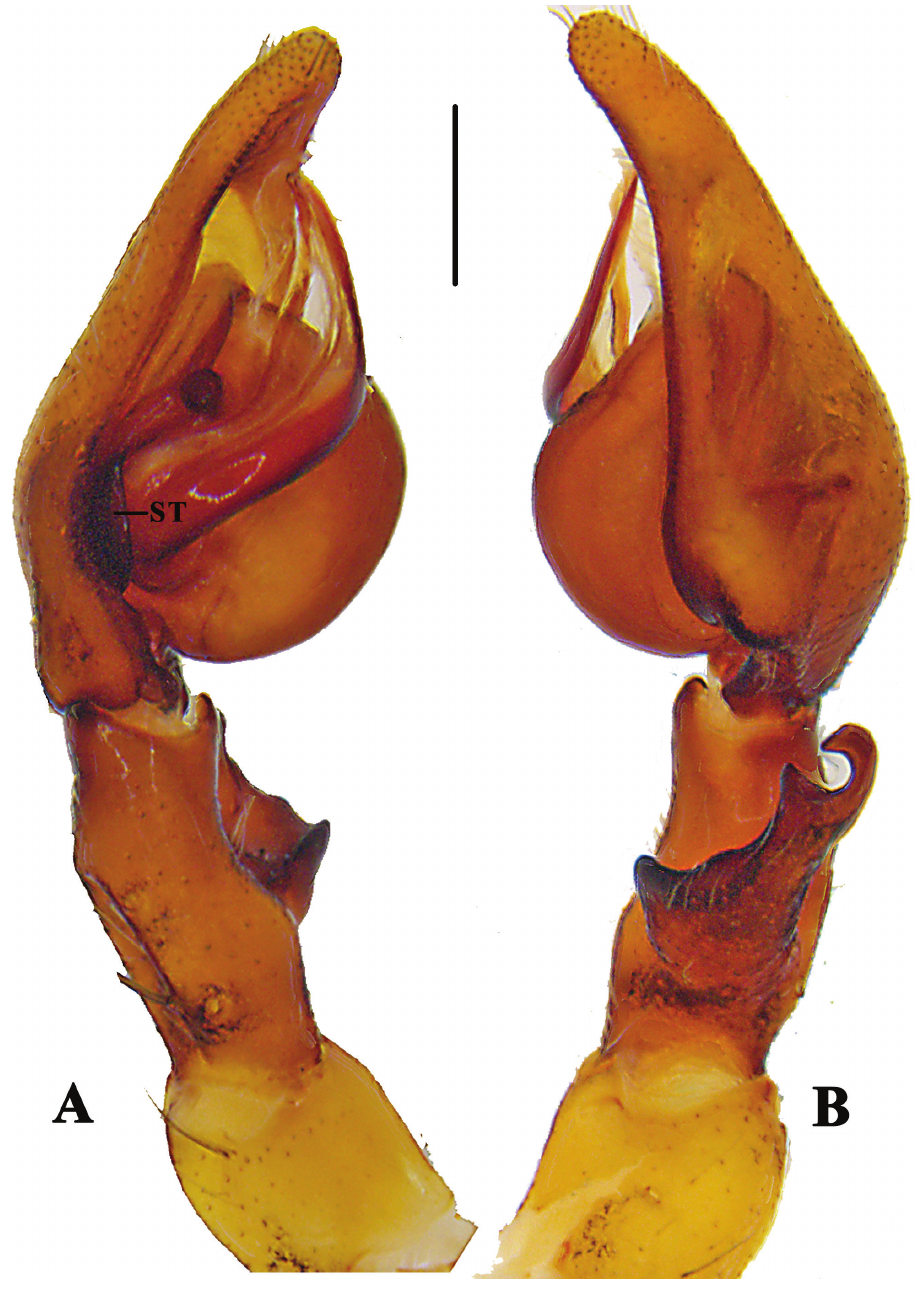
Figure 16. Pseudopoda yunnanensis Yang & Hu, 2001 A left male palp, prolateral B same, retrolateral. Abbreviation: ST–subtegulum. Scale bar: